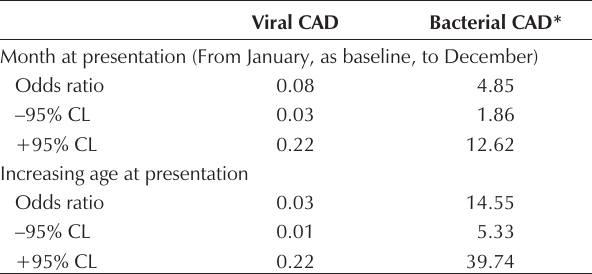
*Separate logistic regression models. CL Confidence